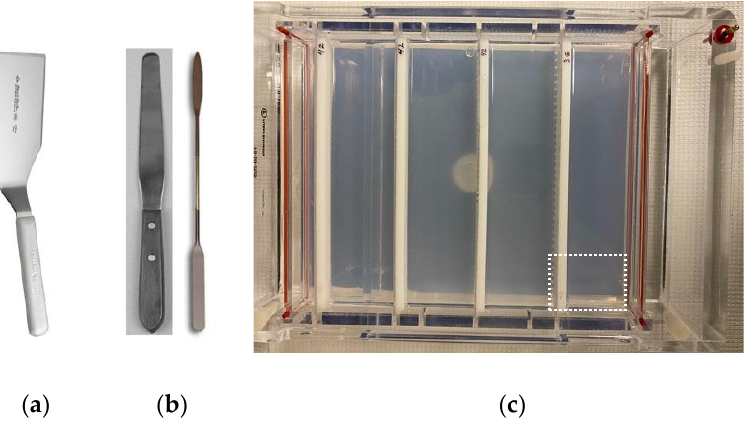
Figure 2. Convenience Gels. ( a ) Because “spatulas” have different shapes, depending on their application, a photo of a spatula is provided that is well-suited for slicing an appropriately sized gel from the Convenience Gel and transferring it to a working gel box; ( b ) a smaller spatula may also be required to help lift the excised gel piece from the Convenience Gel casting box; ( c ) a “Convenience Gel” with 4 rows of combs. Squares are cut from the Convenience Gel, as indicated by white dotted lines. Gel squares are transferred to a new gel box and used for gel electrophoresis.